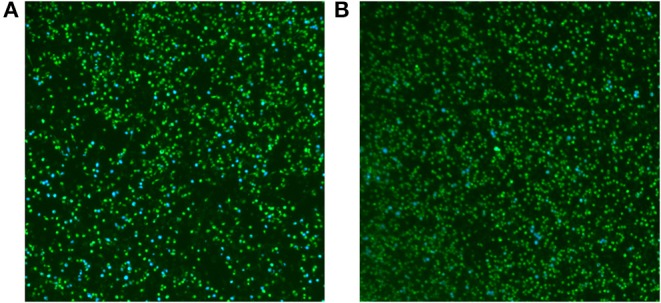
Translocation of the effector VceC into mouse macrophages RAW264.7 infected by M1981 (A) and RM57 mutant strain (B). Cells in which translocation of the fusion protein has occurred appear as blue. The result was a representative individual experiment repeated three times.